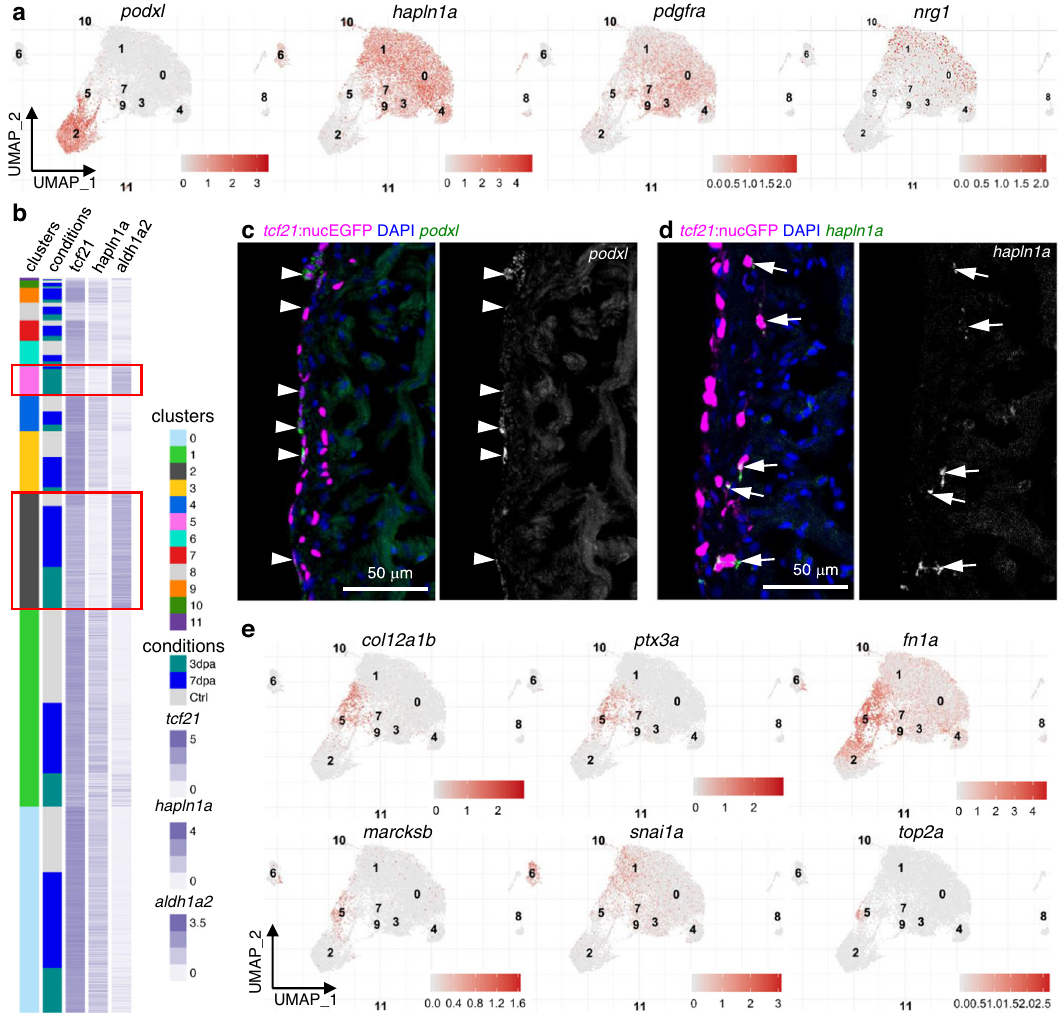
Fig. 3 | The epithelial and mesenchymal subsets of the epicardium. a Normalized expression of marker genes on UMAPs (3 samples combined). b Heatmap of 3 marker genes: tcf21 , aldh1a2 , and hapln1a . Normalized expression values are shown; cells were sorted by cluster membership. Clusters 2 and 5 are highlightedinredframes. c Imagesofa3dpaheartsectionshowingtheventricular wallwith tcf21: nucEGFPinmagentaandHCRstainingof podxl ingreen.Nucleiwere stained with DAPI (blue). A single-channel image of podxl is shown in grayscale on